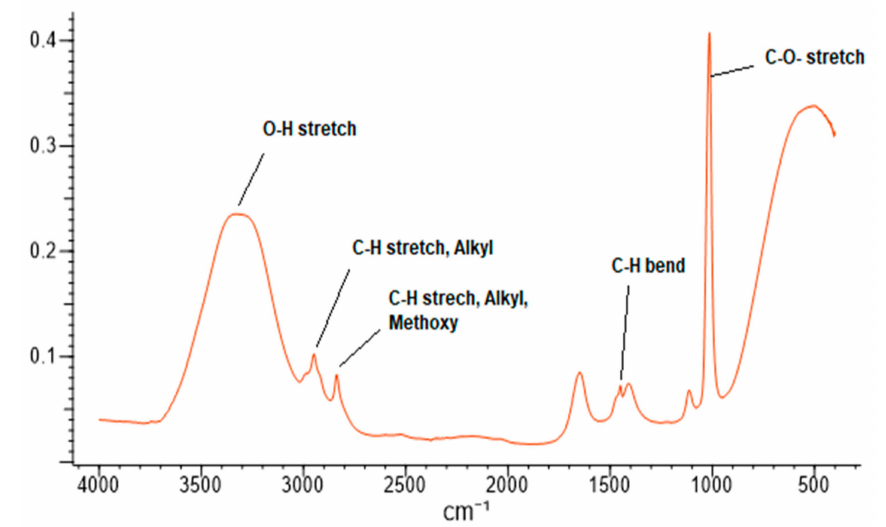
Figure 5. FTIR bands of garlic bulb